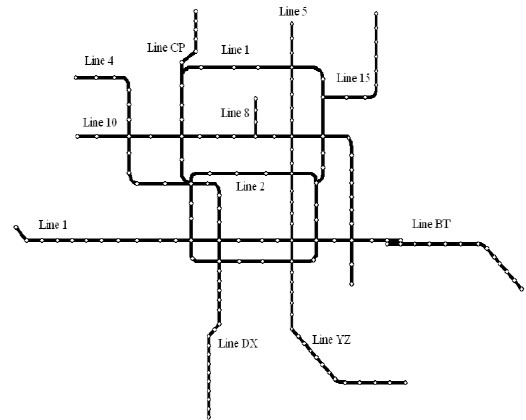
Figure 4. Tested subway network of Beijing